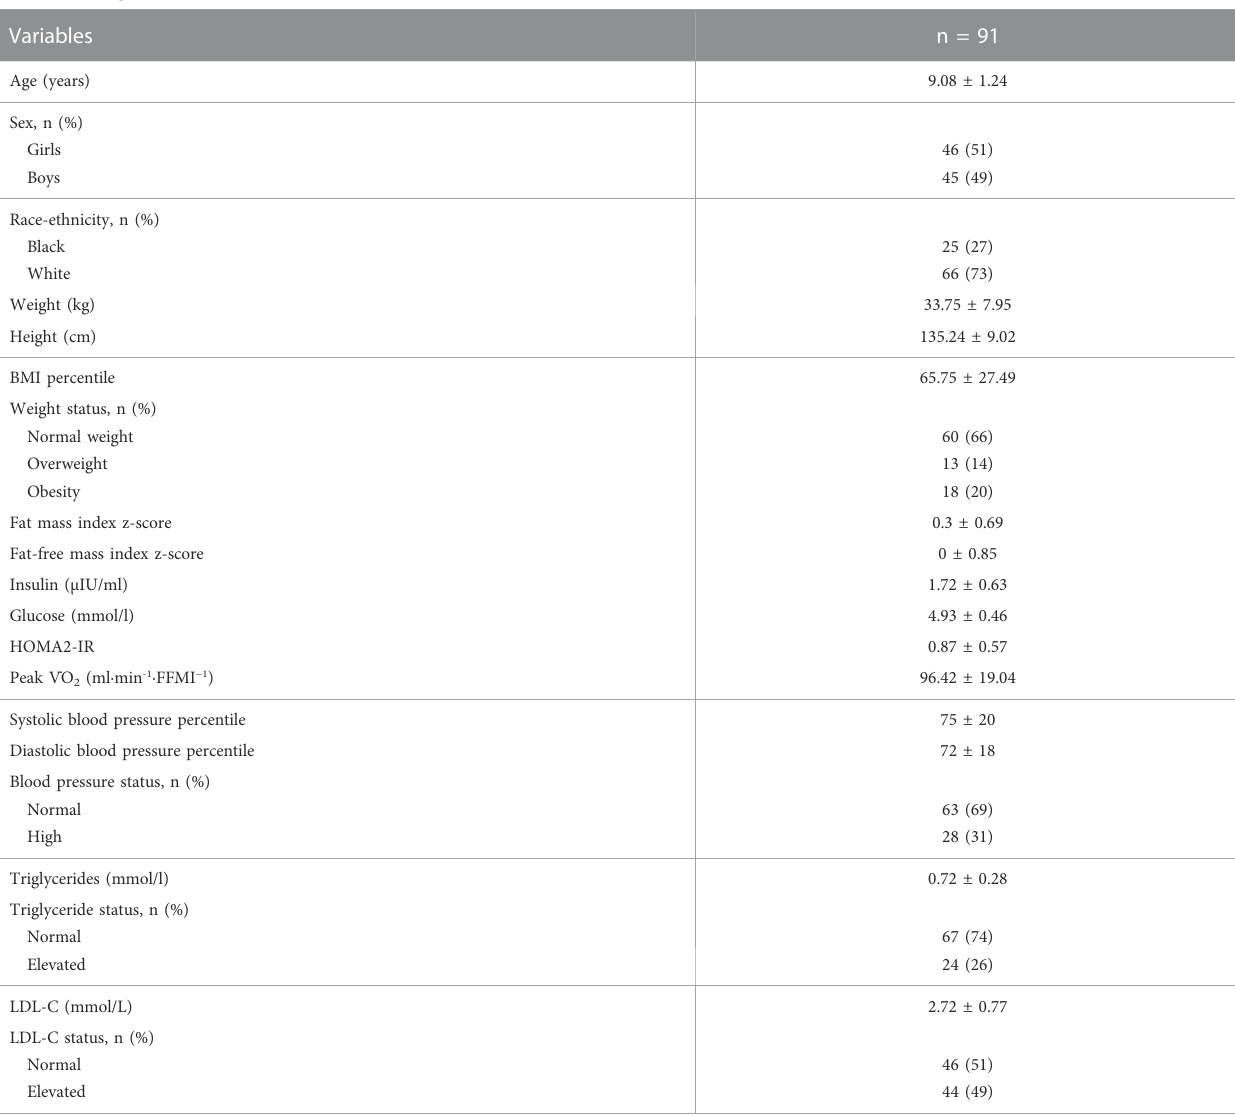
TABLE 2 Participant characteristics.